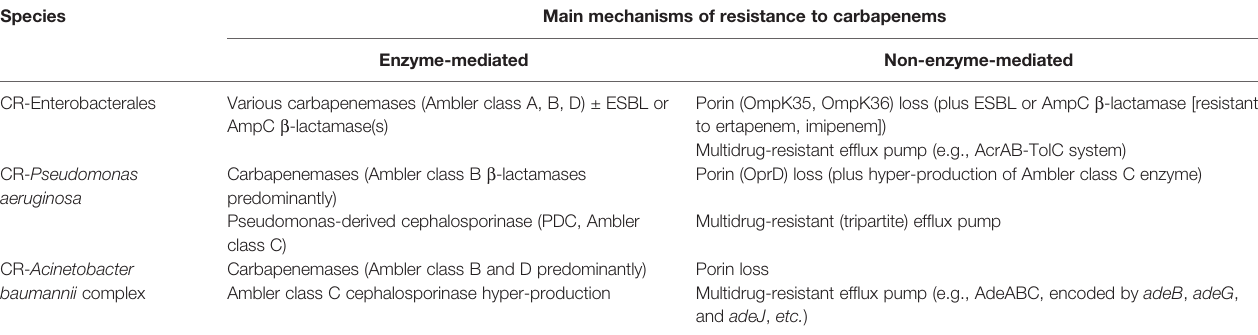
TABLE 2 | The mechanisms of carbapenem resistance in carbapenem-resistant (CR) Enterobacterales species, CR- Pseudomonas aeruginosa , and CR- Acinetobacter baumannii complex.